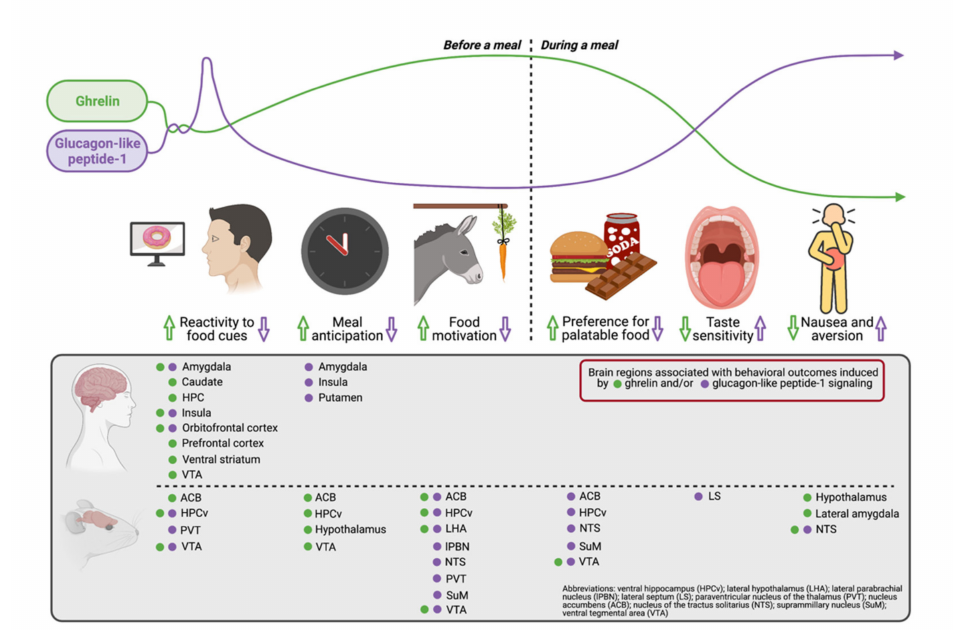
Figure 1. Overview of ghrelin (green) and glucagon-like peptide-1 (purple) circulating levels in relation to a meal ( top row ) and the competing actions ( ↑ increase or ↓ decrease) of these systems on distinct behavioral domains related to food reward ( middle row ) and associated sites of actions based on human and rodent model results ( bottom row